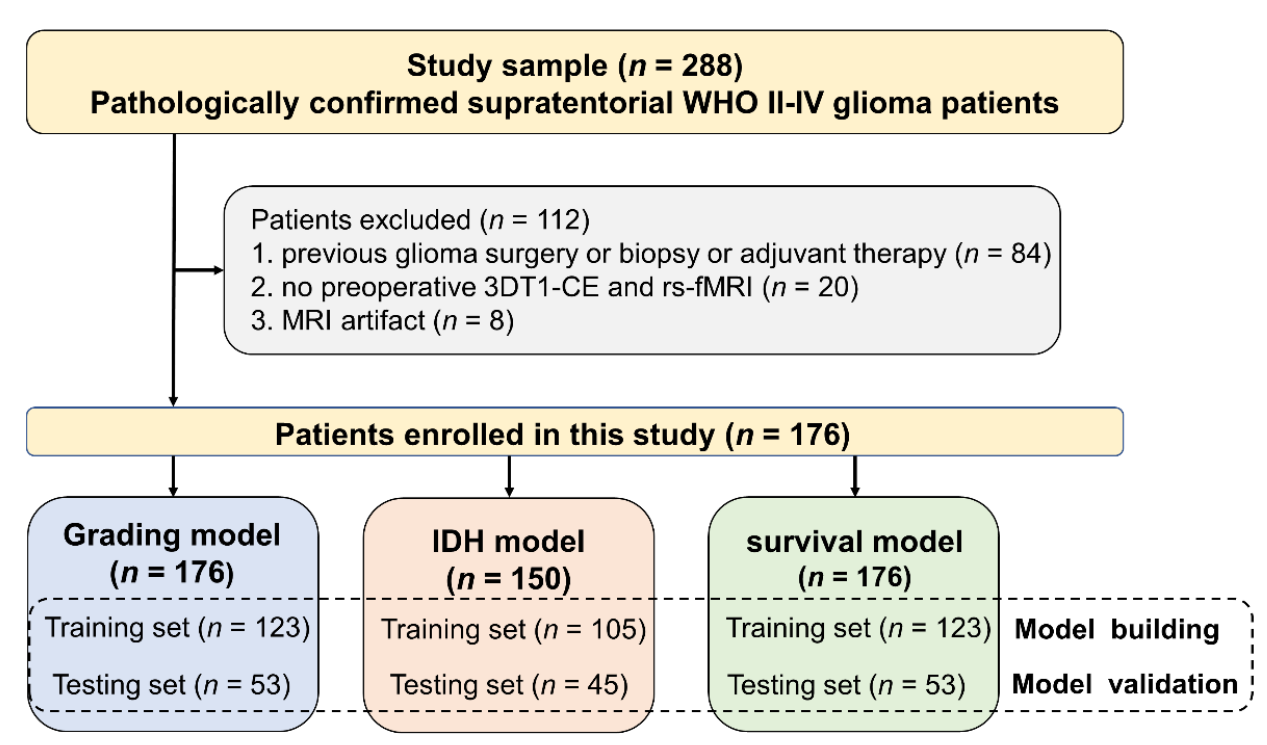
Figure 1. Flowchart of the inclusion and exclusion criteria for patients.